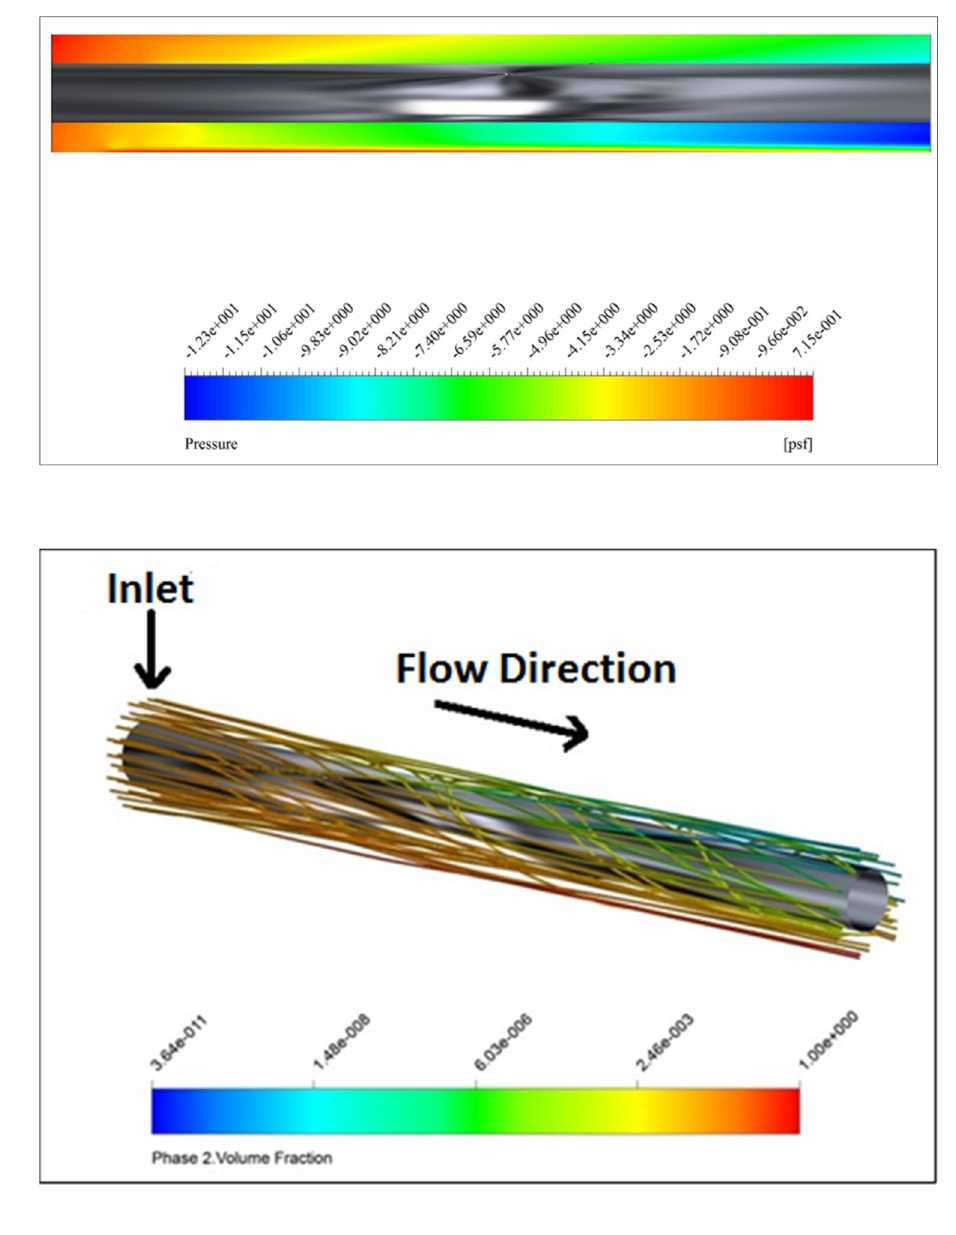
Fig. 11 Pressure contour in a horizontal cross section